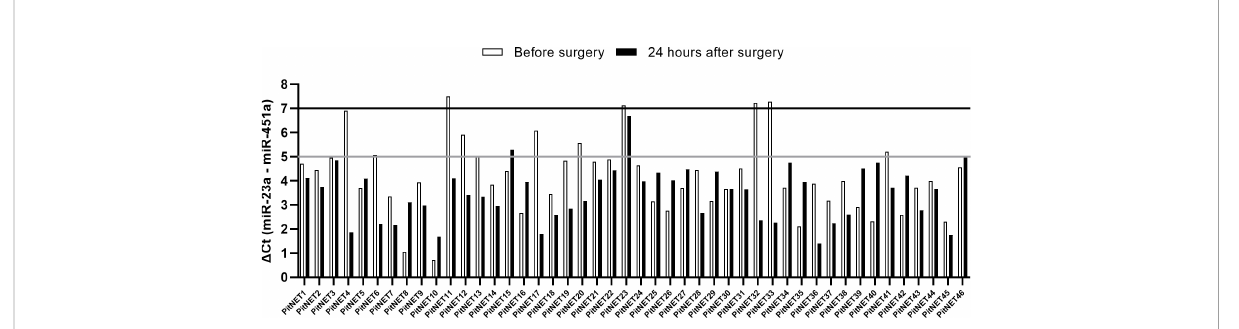
FIGURE 2 Results of miR-23a and miR-451a hemolysis test. D Ct (miR-23a - miR-451a) < 5 indicates no presence of hemolysis, D Ct between 5 and 7 indicates risk of hemolysis, D Ct > 7 indicates that the sample is